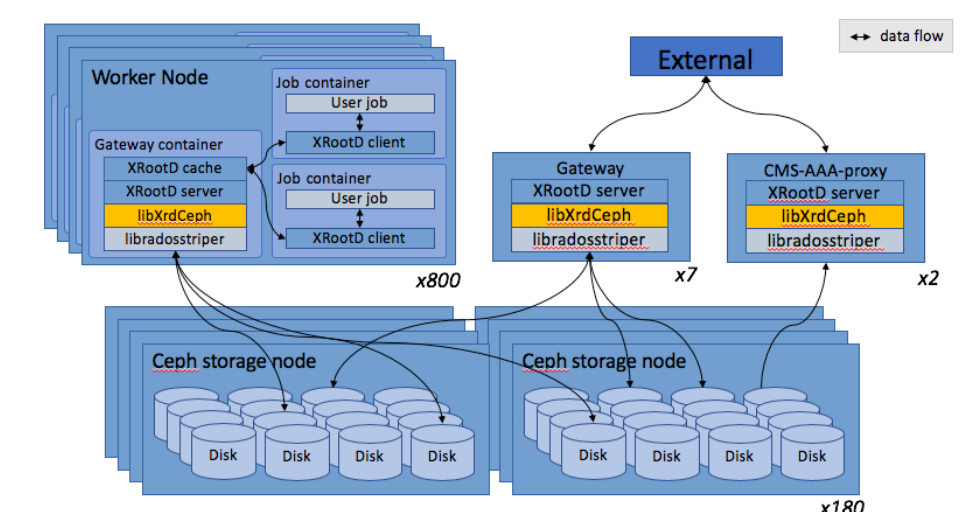
Figure 1: XRootD interactions with Echo